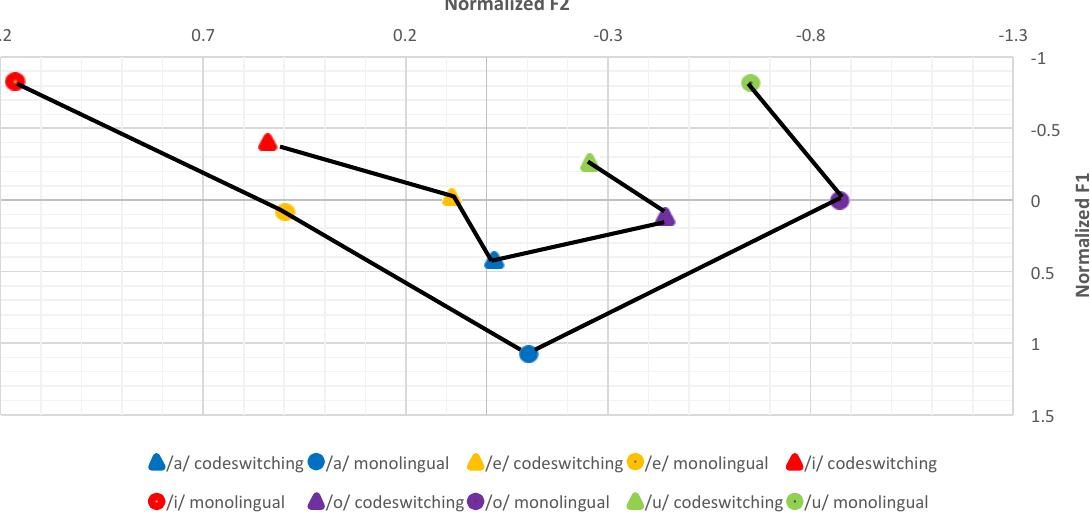
Figure 2. Vocalic triangle of monolingual (circles) and code ‐ switching (triangles) vowels based on the averaged normalized F1 and F2 values.